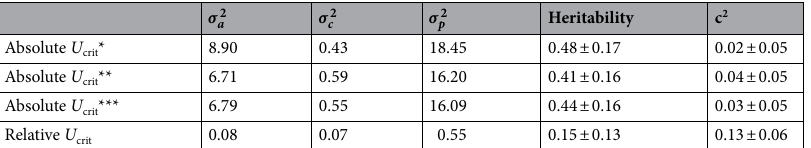
Table 2. Additive genetic variance ( σ heritability and common environmental effect ( c *Absolute U crit without body weight or standard length at swim testing in the model. **Absolute U crit when standard length at swim testing was included in the model as covariate. ***Absolute U crit when body weight at swim testing was included in the model as